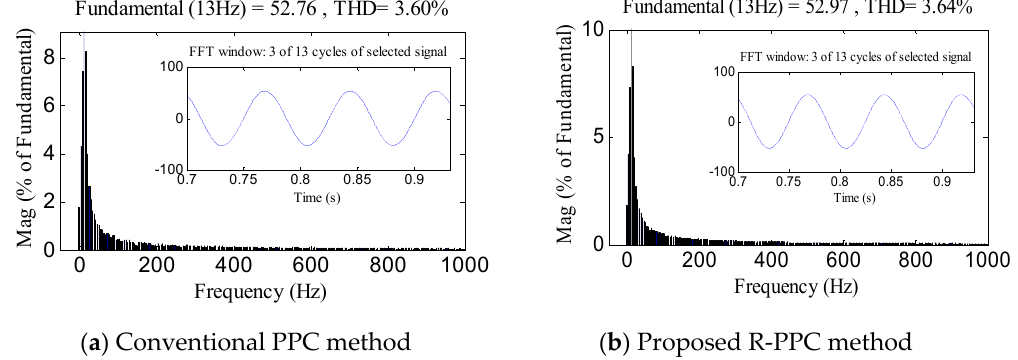
Figure 14. Stator current frequency spectra of the unit motor under the discharge state. ( a ) Conventional PPC method; ( b ) Proposed R-PPC method.